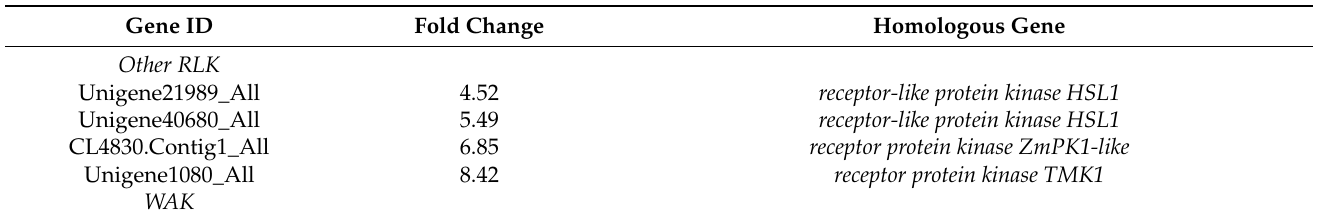
Table 14. The upregulated DEGs related to protein kinases in the leaves of A. canescens under 100 mM NaCl, but not under control conditions, for 24